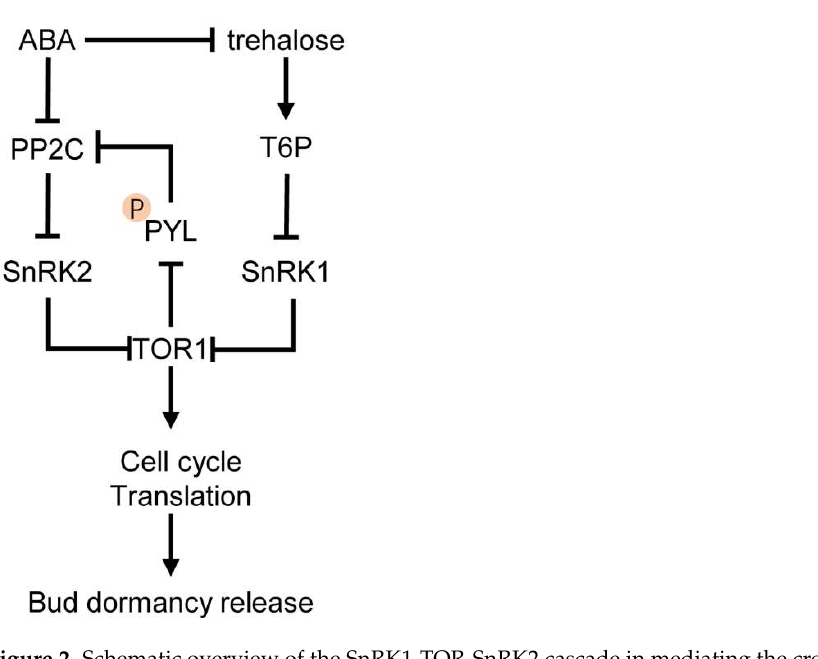
Figure 2. Schematic overview of the SnRK1-TOR-SnRK2 cascade in mediating the crosstalk between ABA with trehalose during bud dormancy release. SnRK1 signaling keeps and switches energy used for rapid growth and development toward enhanced stress tolerance and survival with low energy. SnRK1 can be functional by repressing plant growth and the activity of TOR kinase. In addition, SnRK1 signaling cross-talks with and actives ABA signaling together with SnRK2. SnRK2 represses TOR signaling by direct phosphorylation, leading to TOR complex dissociation. In favor conditions, TOR kinase backwards represses SnRK2 signaling via phosphorylation of the PYR1-LIKE (PYL) and active PP2C. TOR1 promotes the transcription of genes involved in cell-cycle progression and translation of ribosomal protein mRNAs in plants. SnRK1 is repressed by high energy signals, such as trehalose-6-P (T6P). Note that this overview summarizes interactions reported in different species or environmental condition, which are not necessarily occurring simultaneously. Full lines and dashed lines specify established.